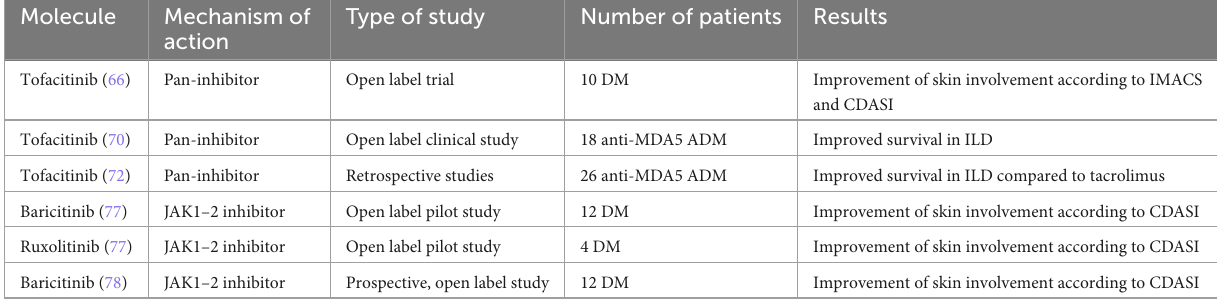
TABLE 1 Published clinical trials on the use of JAK inhibitors in idiopathic inflammatory myopathies. Molecule